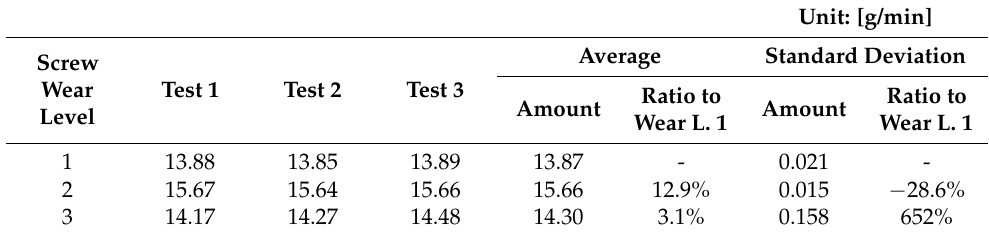
Table 1. Results of the flow rate measurement test according to screw wear level.